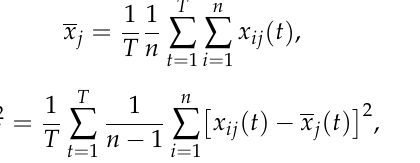
Table 1. Multivariate panel data format for spatail cluster.